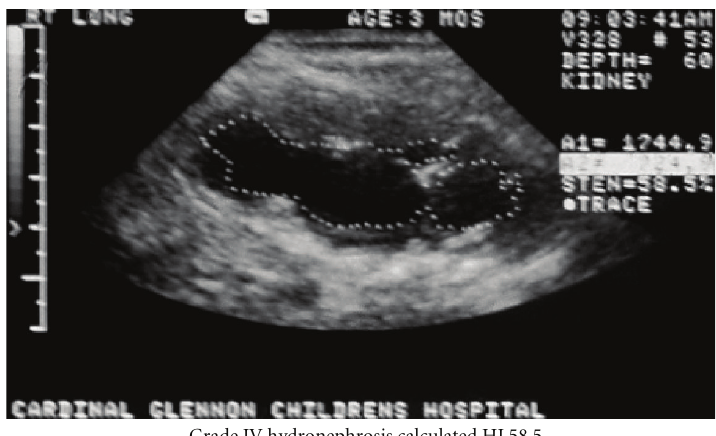
Figure 2: SFU grade IV hydronephrosis; Calculated HI 58.5. The dotted line outlines the renal pelvis [black] as used in calculating HI.